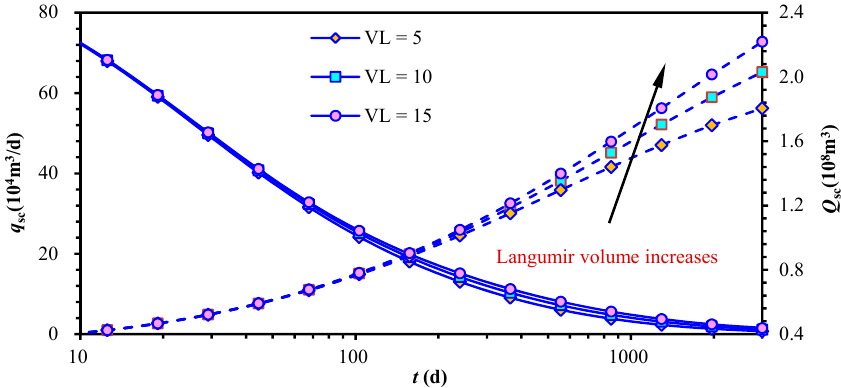
Figure 17. Effect of Langmuir volume on production performance of a MFHW in shale.